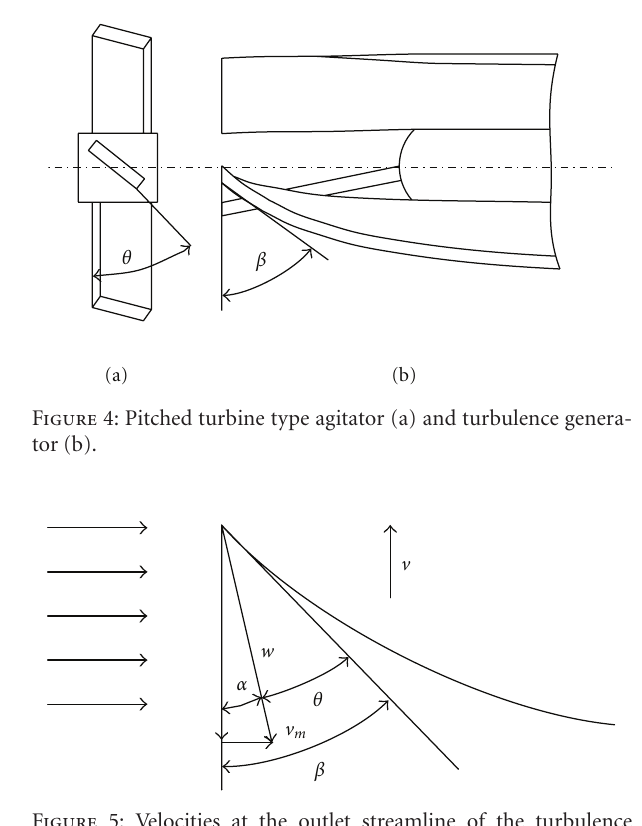
Figure 5: Velocities at the outlet streamline of the turbulence generator.